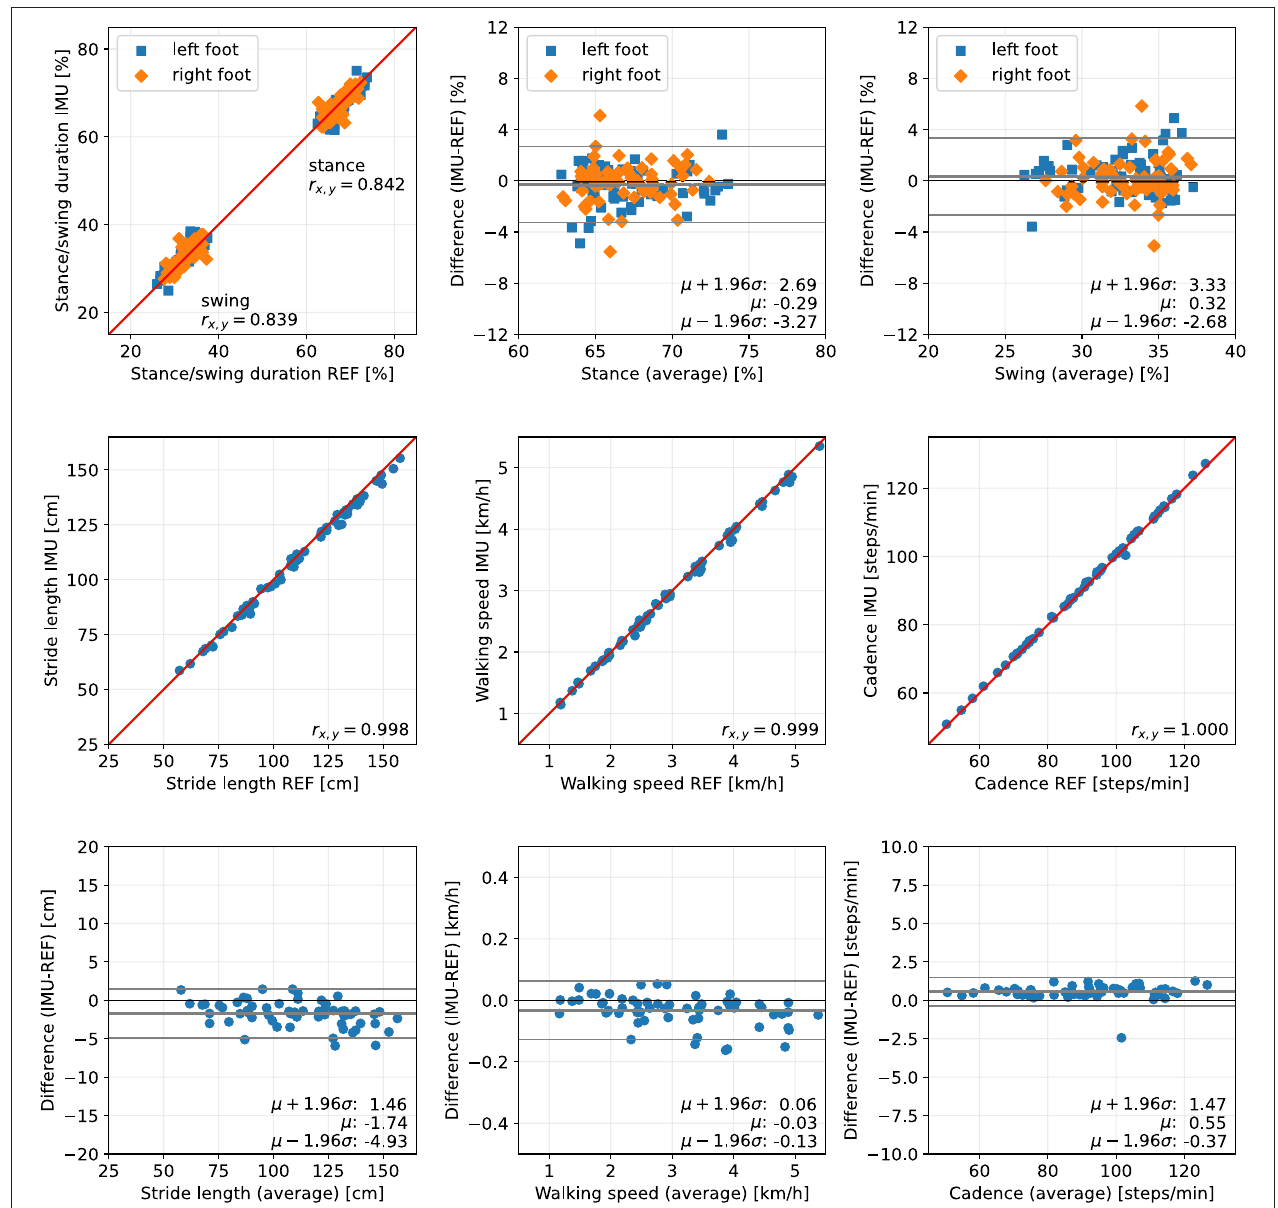
FIGURE 11 | Scatter plots and Bland-Altman plots for stance and swing duration, stride length, walking speed, and cadence of 62 orthopedic patients. Red: 45-degree lines ( y = x ). Values obtained with the proposed IMU-based methods (IMU) are compared to the ground truth from the Zebris reference system (REF). The average deviation is below 1% for gait phase durations, below 2cm for the stride length, below 0.05km/h for the walking speed, and below 1step/min for the